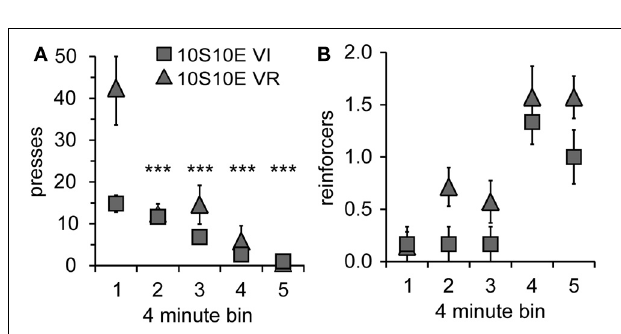
FIGURE 3 | Performance of 10S10E groups during first test session. (A) The number of lever presses per four-minute bin decreased over the session for the 10S10E VR (triangles), but not the 10S10E VI (squares) group. ∗∗∗ Indicates for the VR group the bins that were significantly different from bin 1 ( p < 0 . 001 level of significance). (B) The number of reinforcers received per four-minute bin increased for both groups over the session, but the 10S10E VR group received more reinforcers than the